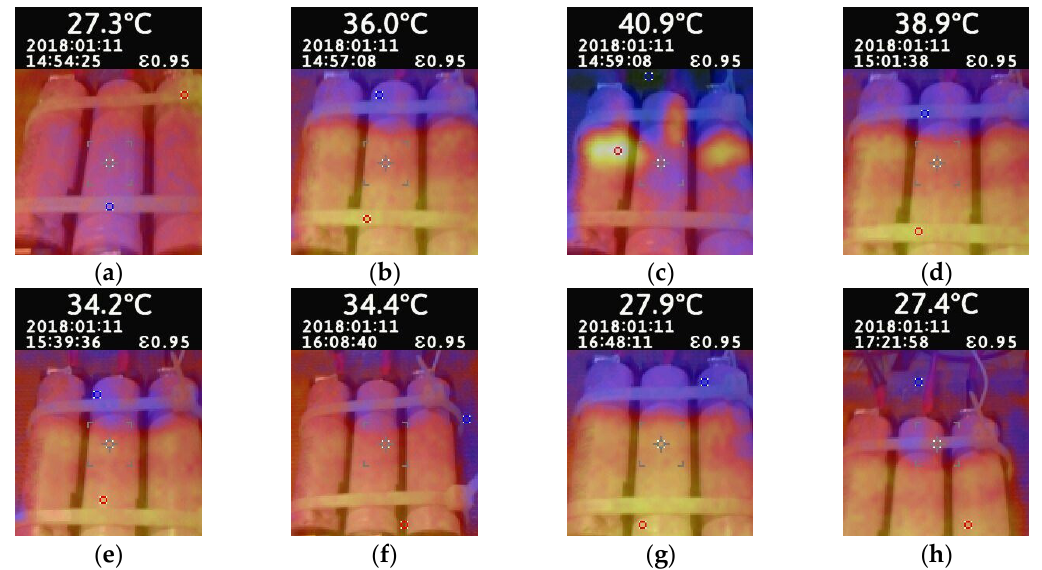
Figure 13. Temperature measurements during the proposed charging scheme at different time intervals, ( a ) at t = 0 s, ( b ) at t = 163 s, ( c ) at t = 283 s, ( d ) at t = 433 s, ( e ) at t = 2711 s, ( f ) at t = 4455, ( g ) at t = 6862, and ( h ) after complete charging.